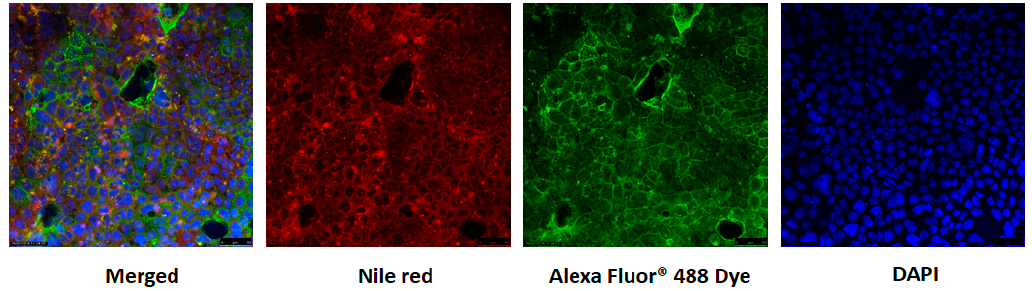
Figure 5. CLSM of Caco-2 cells grown on glass coverslips after exposure to lipid-based nanoemulsions (mean droplet size is 170 nm) for 4 h. Cell nuclei were stained in blue with DAPI; β -actin labelled with Alexa Fluor 488 appear as green spots; nanoemulsion lipid labeled with Nile red; first picture displays the merged ( x,y ) image of stains of Caco-2 cells after incubation with nanoemulsion. Scale bar indicates 15 μ m. The data were expressed as mean ± standard with three independent replicates.